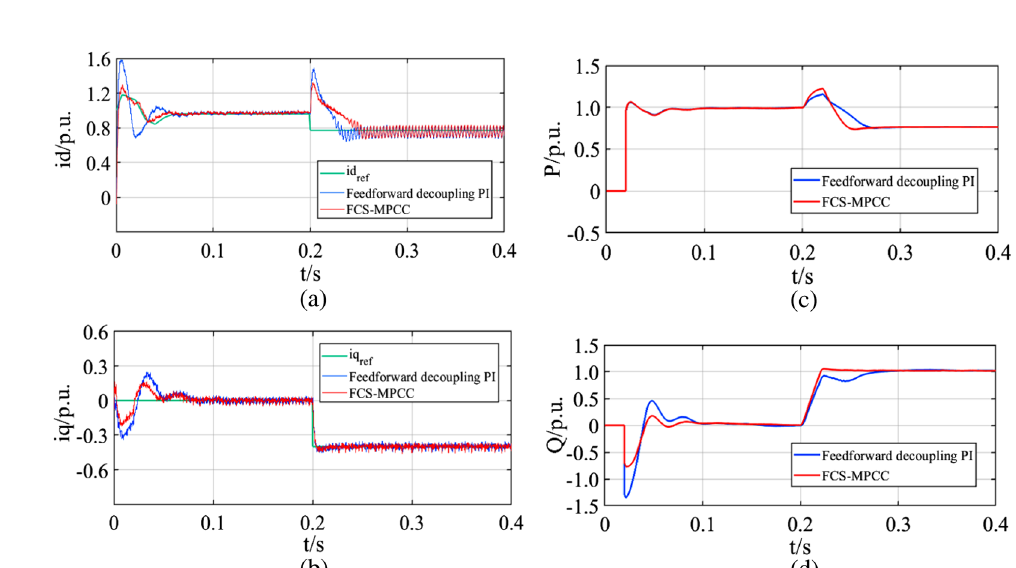
Fig. 16 Comparisons of waveforms with FCS-MPCC and traditional feedforward decoupling PI control after changing initial conditions a active current, b reactive current, c inverter output active power, d inverter output reactive power